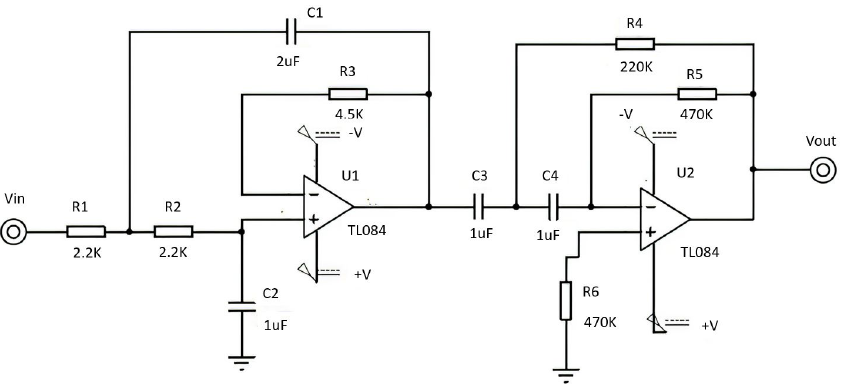
Figure 10. Second order filters in Butterworth configuration at 40 dB/decade. It helps to remove frequency components that are outside the bandwidth of the EOG signal, 0.5 Hz to 50